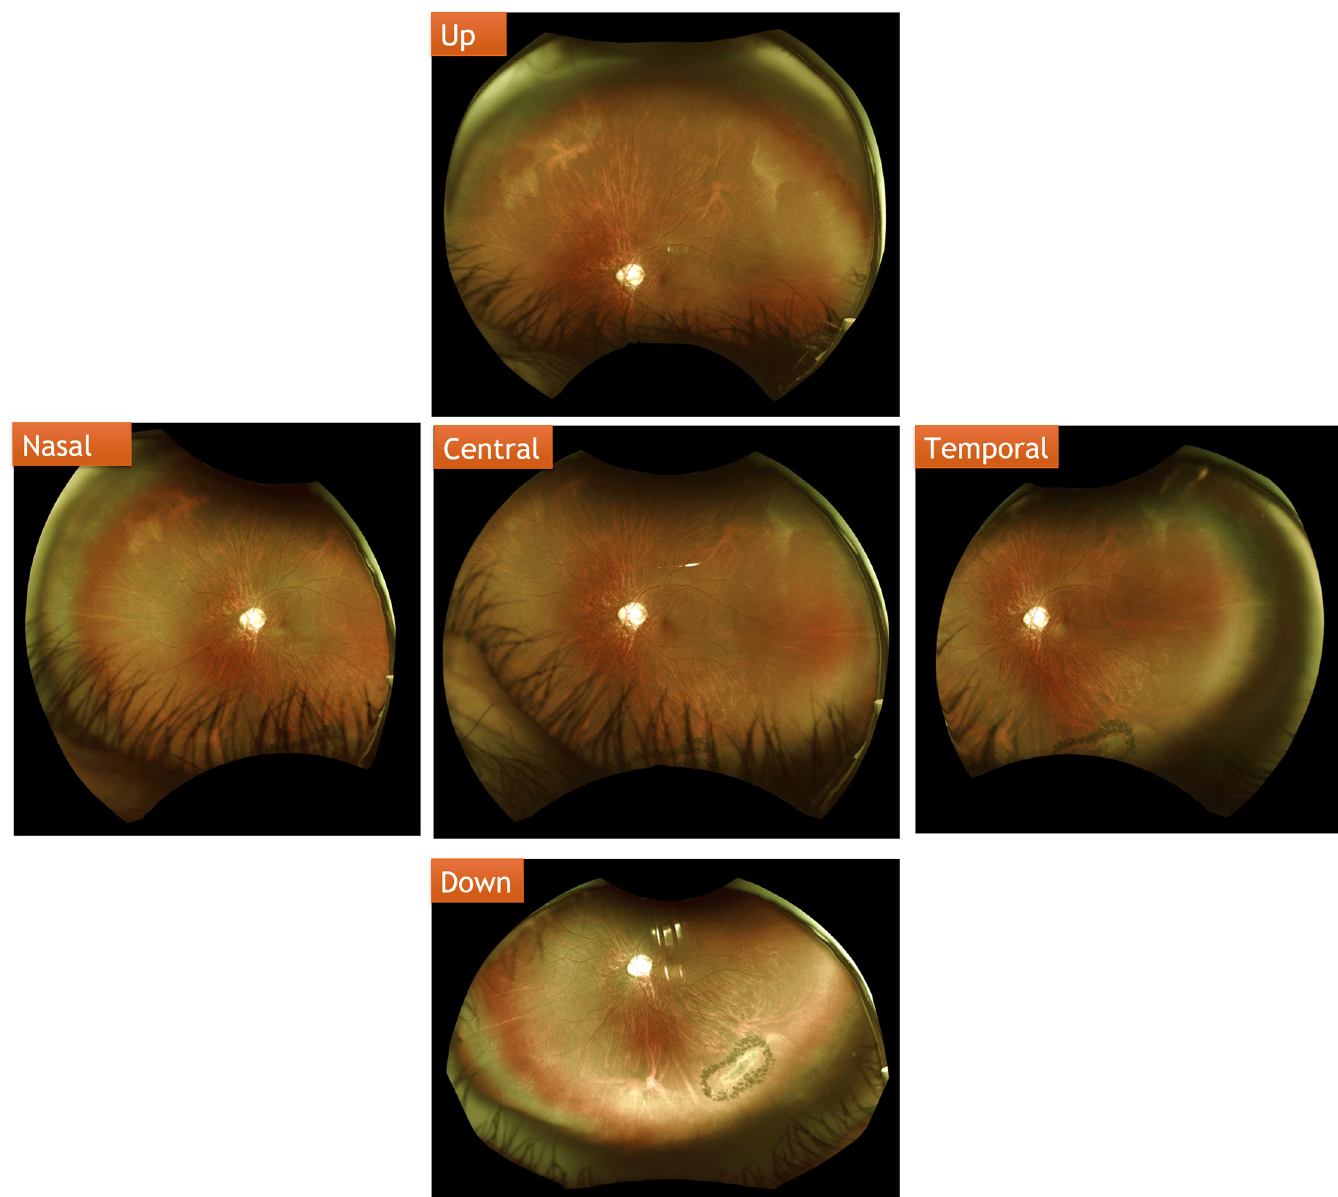
Fig 1. Central and four gaze-steered UWF images. Examples of the central image and four gaze-steered images (up, down, temporal, and nasal) taken during the UWF imaging examination.